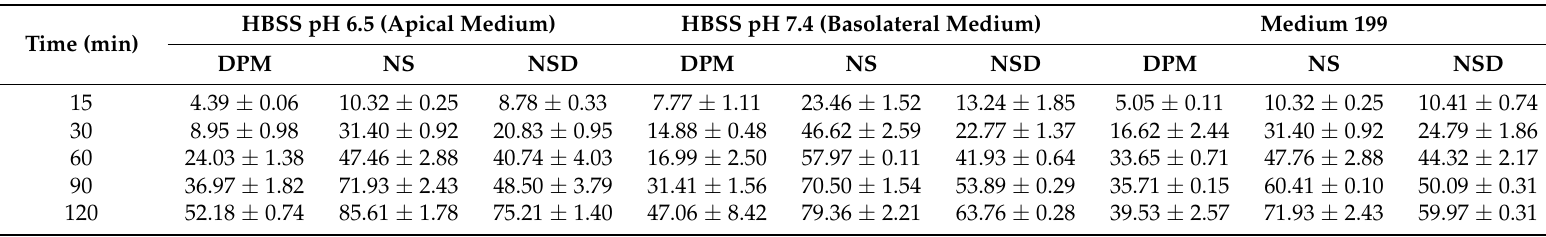
Table 1. The solubility of DPM in different media used during in vitro and ex vivo studies. Values are expressed in µ g/mL as mean ± standard